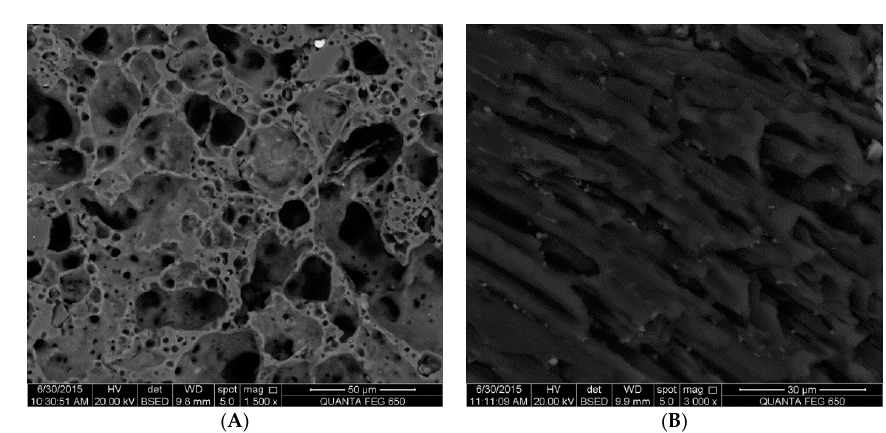
Figure 9. Melting material and unburned carbon in 40%-O 2 slag, SEM back scattering images. ( A ) Porous and melting materials; ( B ) Unburned carbon.